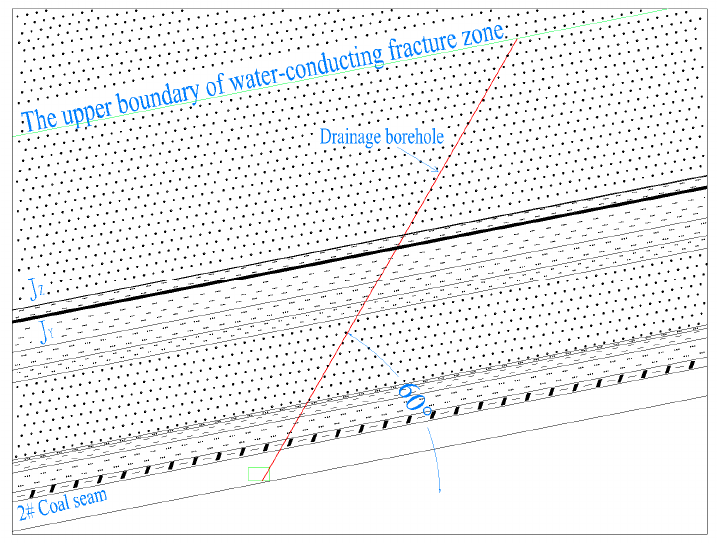
Figure 14. Drilling methods.